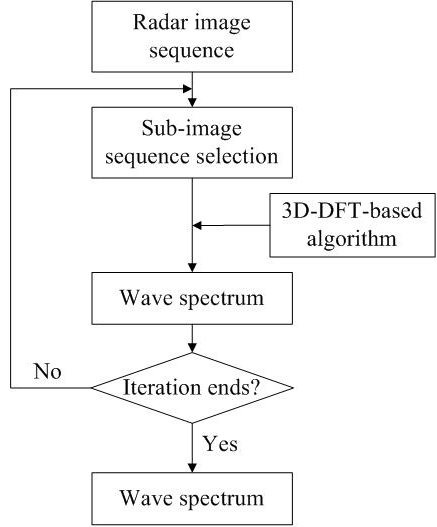
Figure 8. Flowchart of the adaptive recursive positioning method